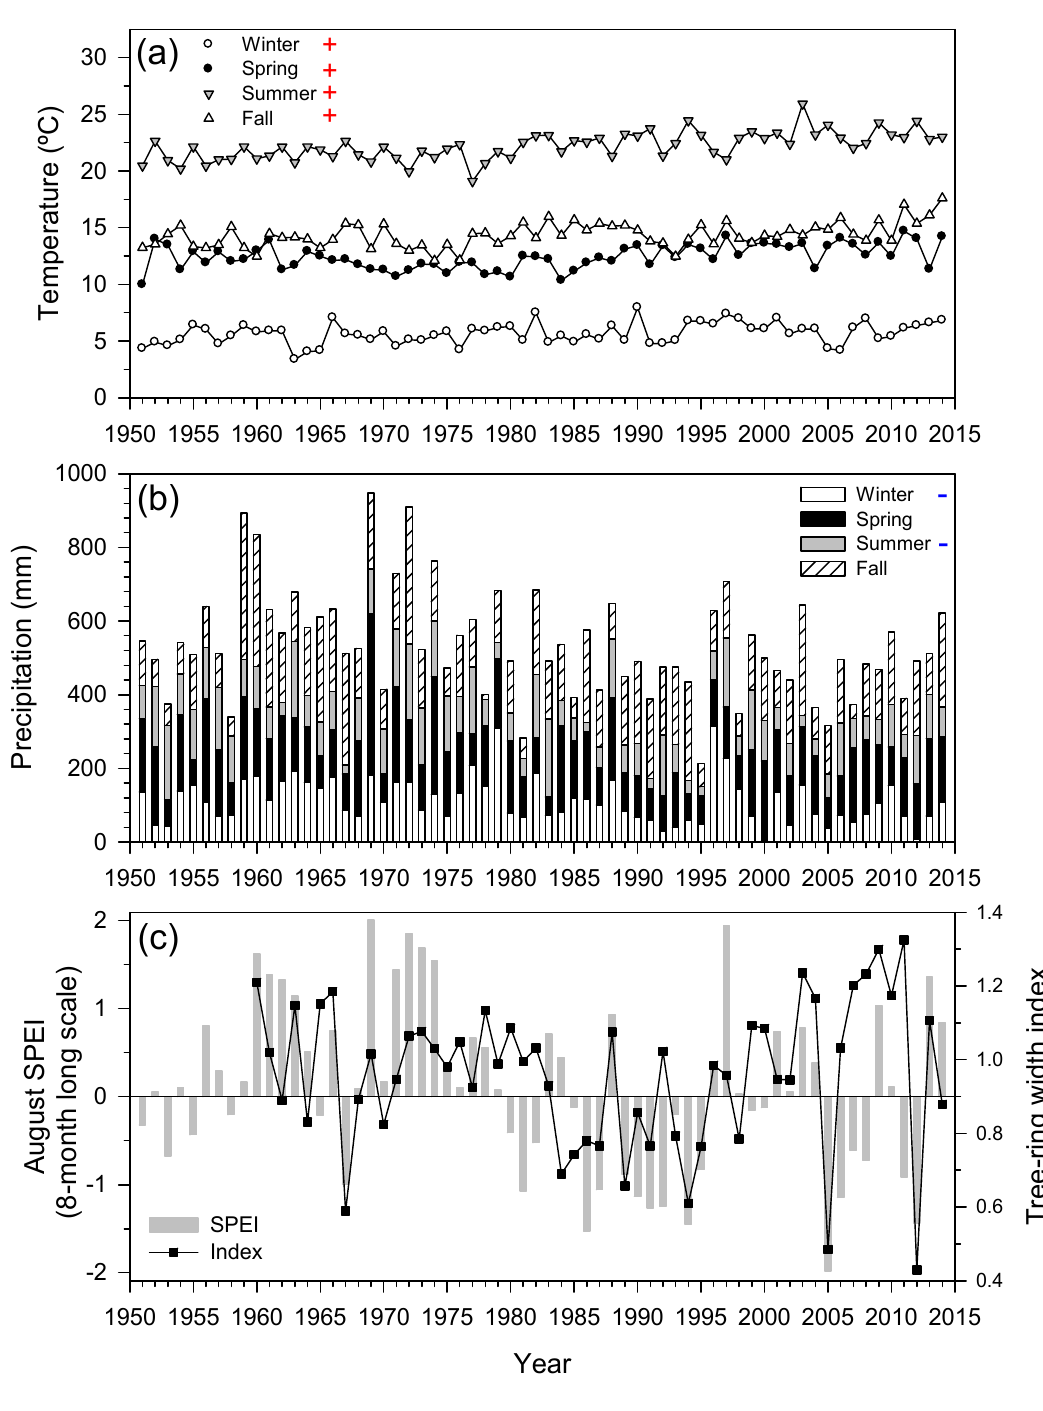
Figure 2. Seasonal climatic trends ( a , b ) and drought patterns (August Standardized Precipitation-Evapotranspiration Index, SPEI, calculated at eight-month-long scales) for the period 1951–2014 in the study area as related to holm oak ring-width index ( c ). In the two upper plots the symbols after the seasons indicate either positive (all seasonal temperatures) or negative (winter and summer precipitation) significant ( p < 0.05) trends based on the Kendall tau